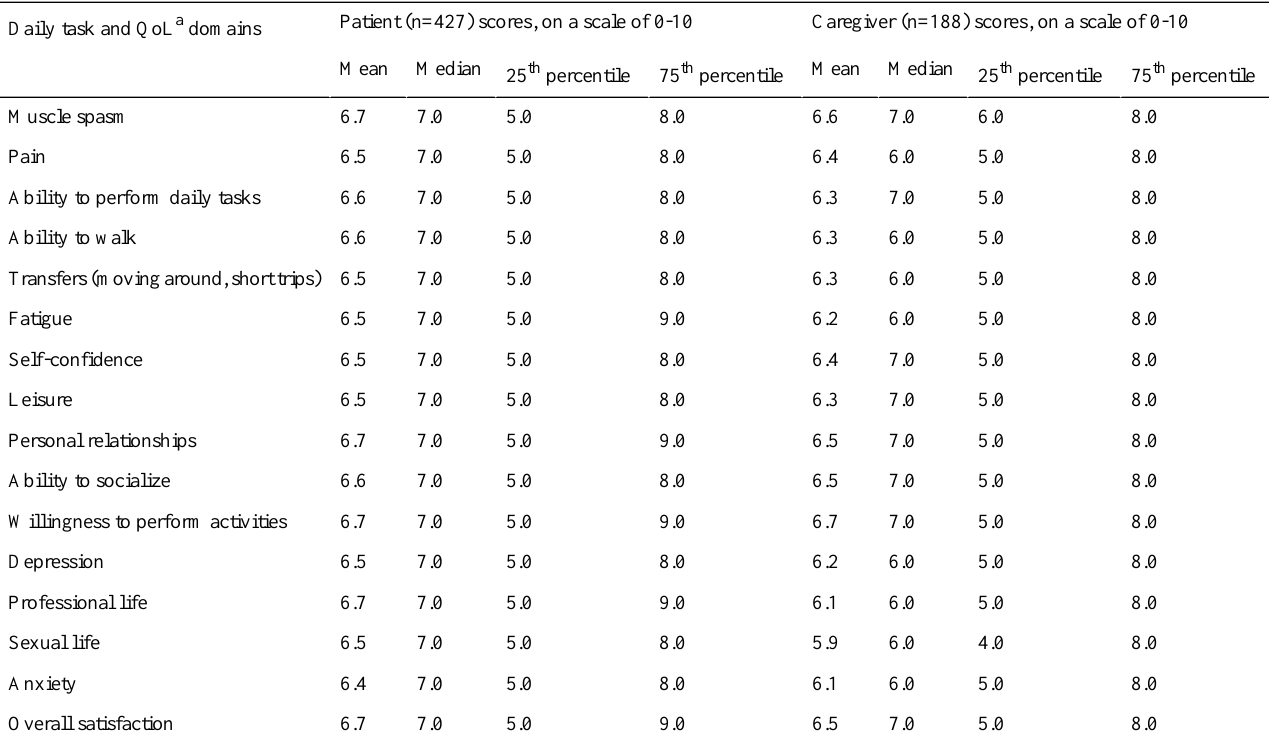
Table 4. Scores for patients’ and caregivers’ responses on improvements in patients’ lives with botulinum neurotoxin type A (BoNT-A) treatment; improvement was rated on a scale of 0-10, where 0=no improvement and 10=greatly improved (n=615).